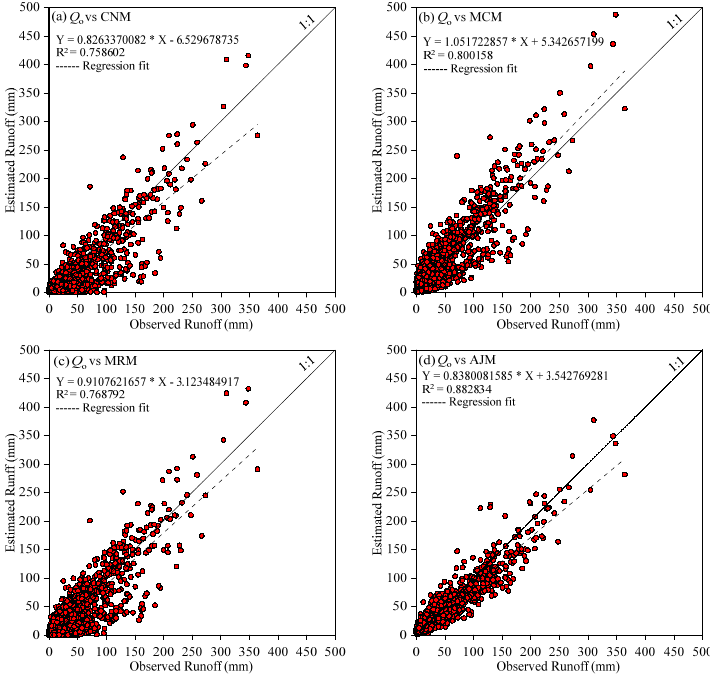
Figure 6. Comparison of events from all watersheds for ( a ) observed runoff ( Q o ) vs. predicted with CNM; ( b ) Q o vs. predicted with MCM; ( c ) Q o vs. predicted with MRM; and ( d ) Q o vs. predicted with AJM.